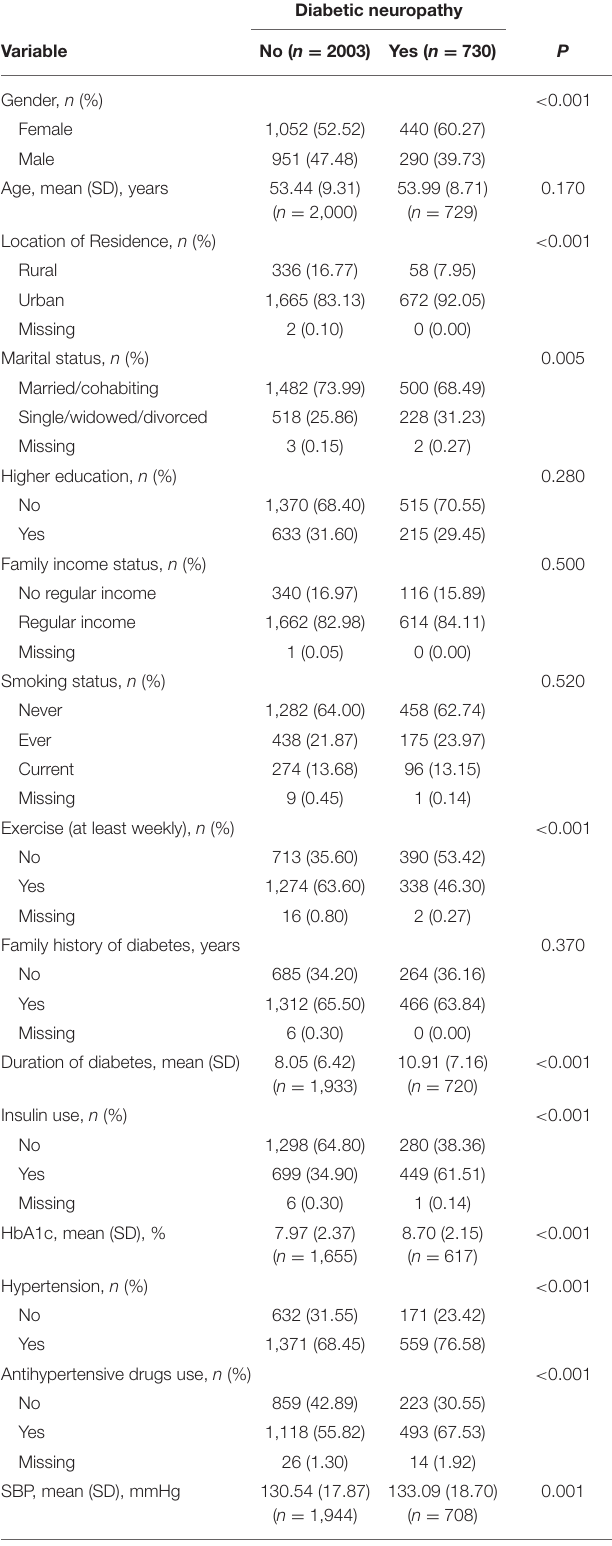
TABLE 2 | Characteristics of the participants by diabetic neuropathy status. Diabetic